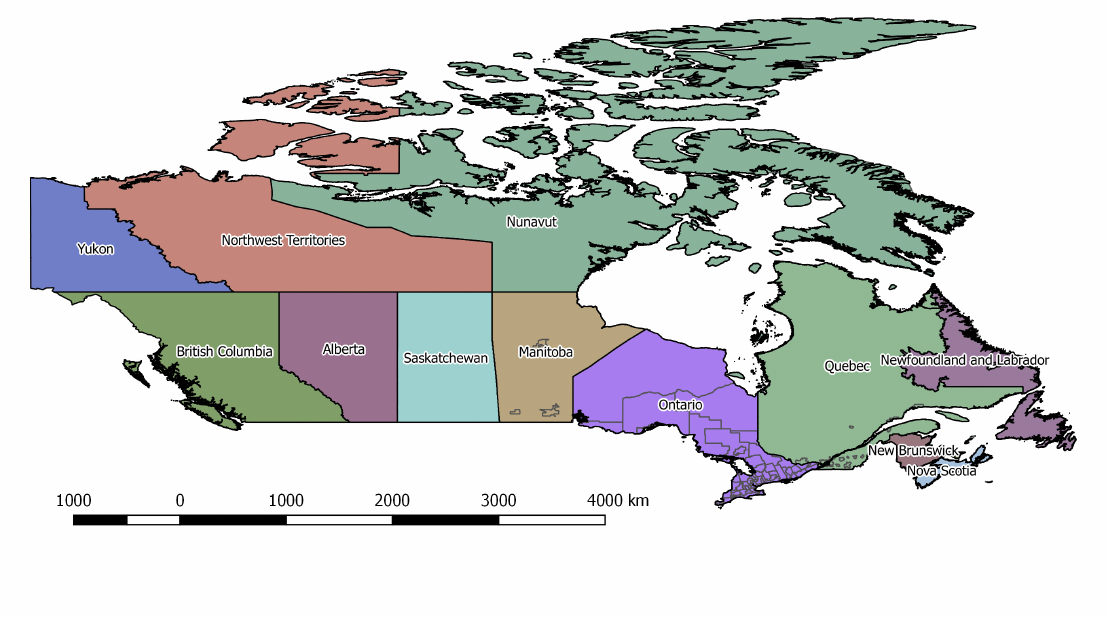
Figure 1. Zones by province for